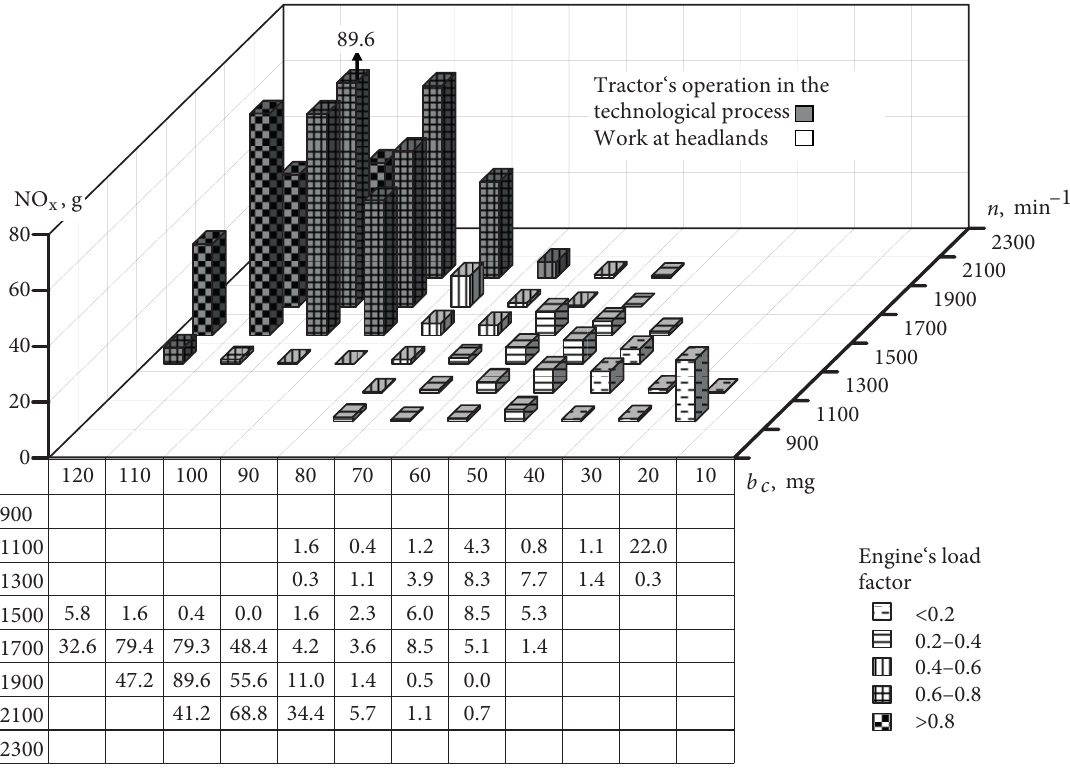
Fig. 12. Distribution of NO emissions during the test period of drilling (3867 s) in the modes of engine speed ( n ) x and cyclic fuel injection quantity ( b c